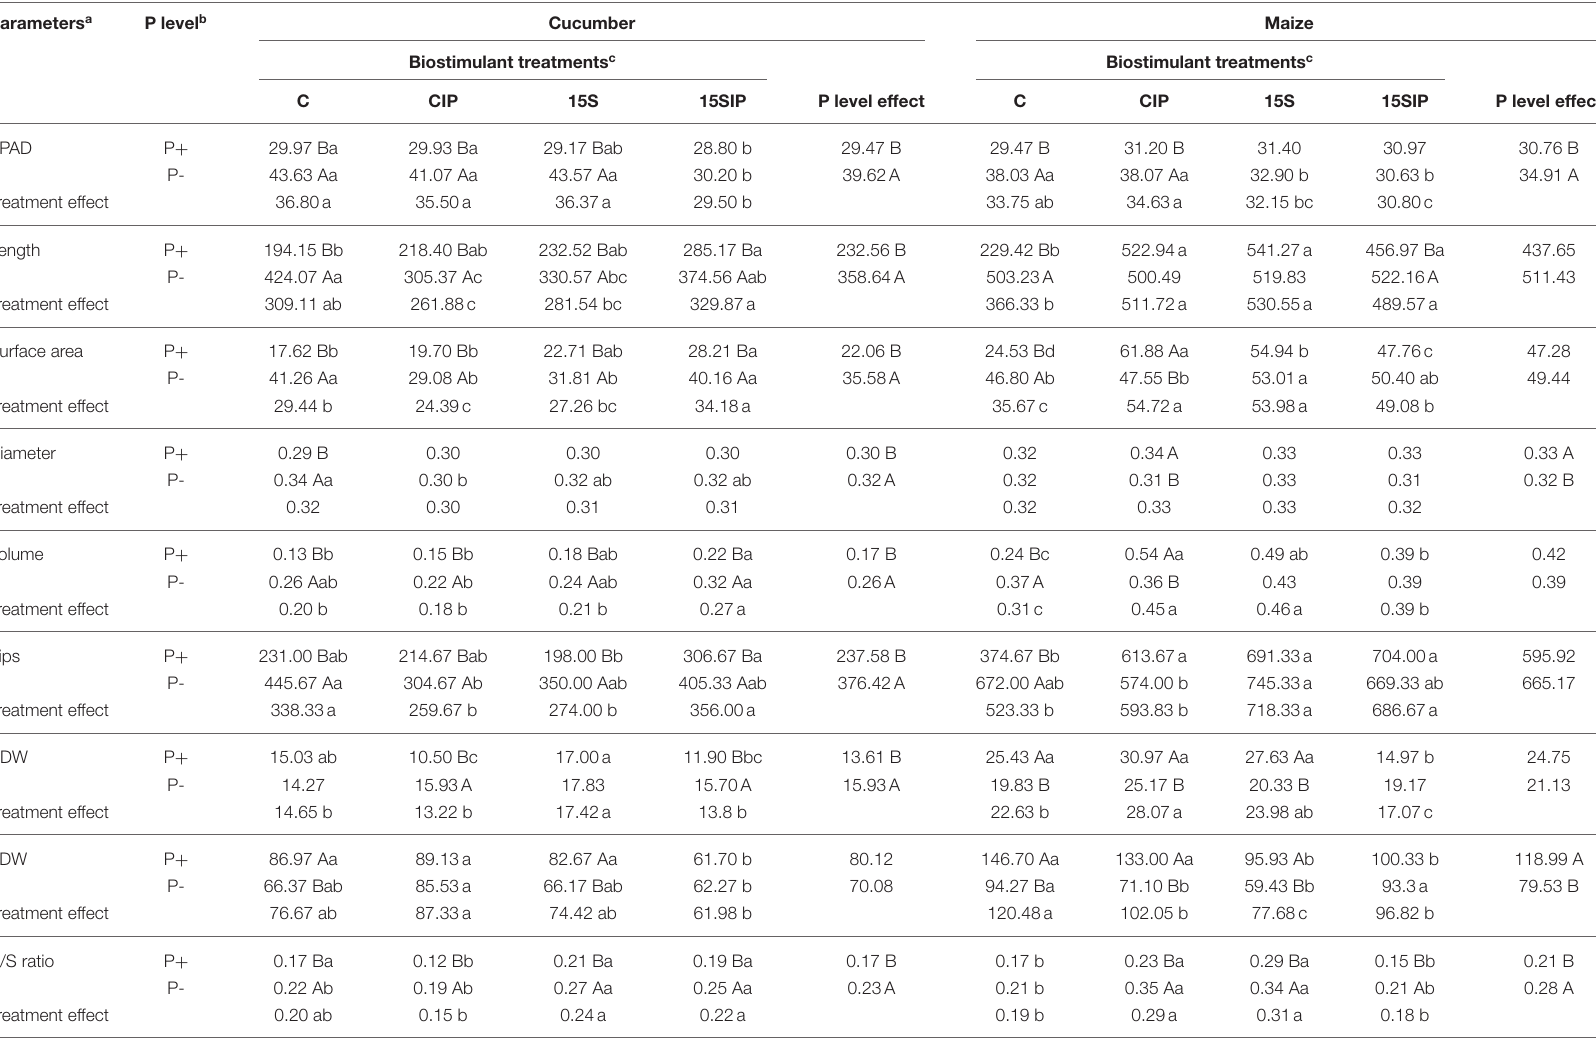
TABLE 1 | Mean values for the morpho-physiological parameters in cucumber and maize grown hydroponically under different P-fertilization levels and different inoculation treatments with Enterobacter 15S. Parameters